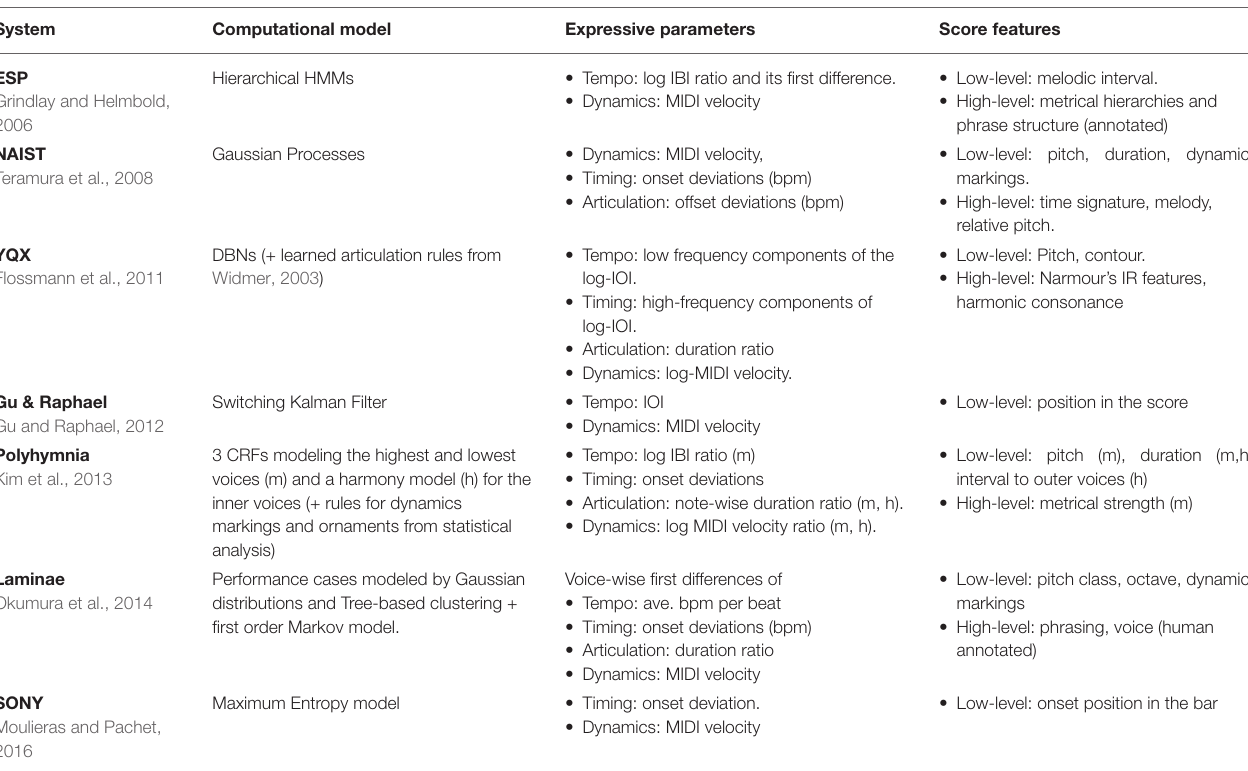
TABLE 1 | Probabilistic models for performance